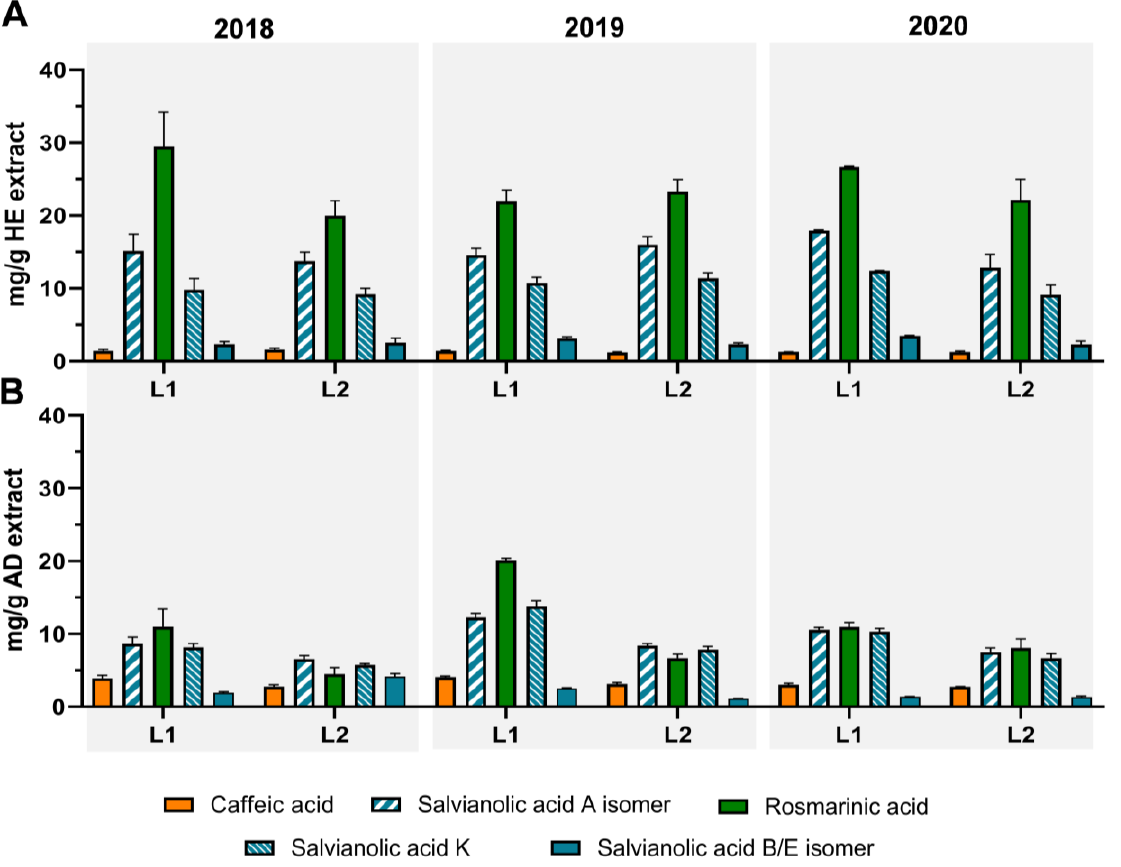
Figure 3. Annual variation (2018–2020 period) of individual phenolic acids in T. carnosus hydroethanolic ( A ) and aqueous decoction ( B ) extracts, as obtained by HPLC-DAD analysis.